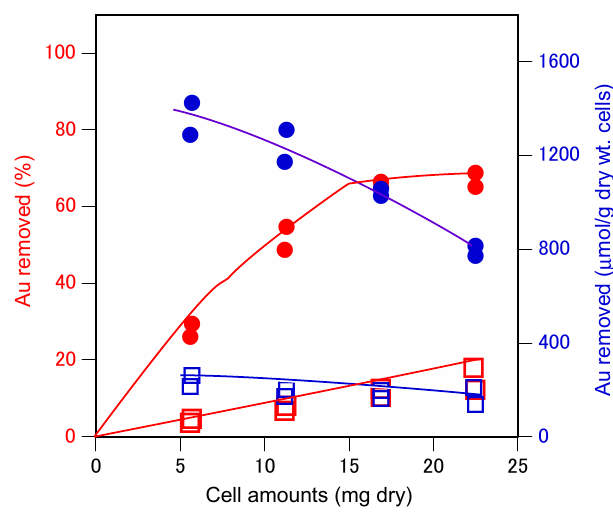
Figure 4. Effect of the cell amounts of C. krusei AHU3993 used on gold removal. Red symbols: Au removed (%), blue symbols: Au removed ( μ mol/g dry weight cells), circle symbols, contact 72 h (biomineralization), square symbols 1 h (biosorption).